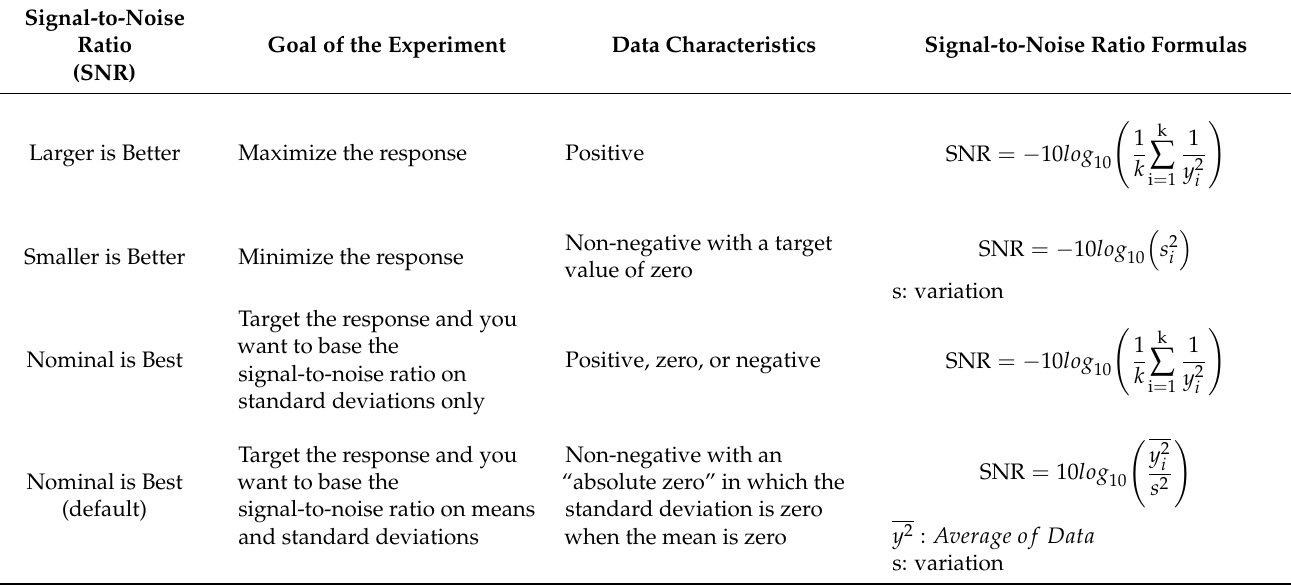
Table 5. Types of Signal-to-noise